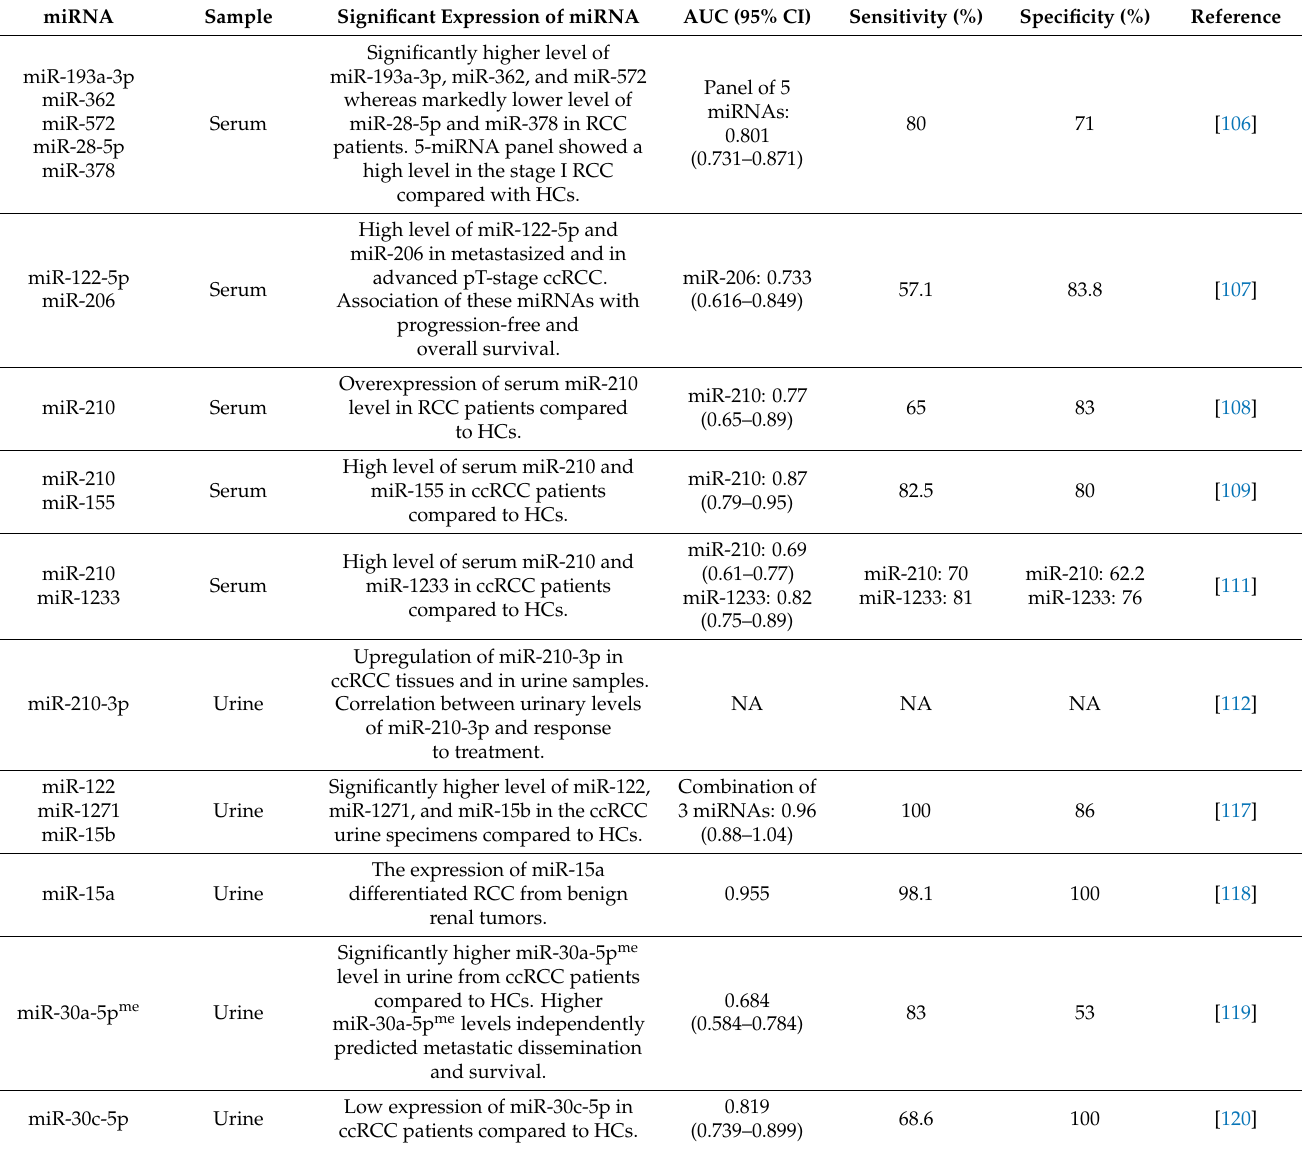
Table 2. microRNAs as potential diagnostic biomarkers in